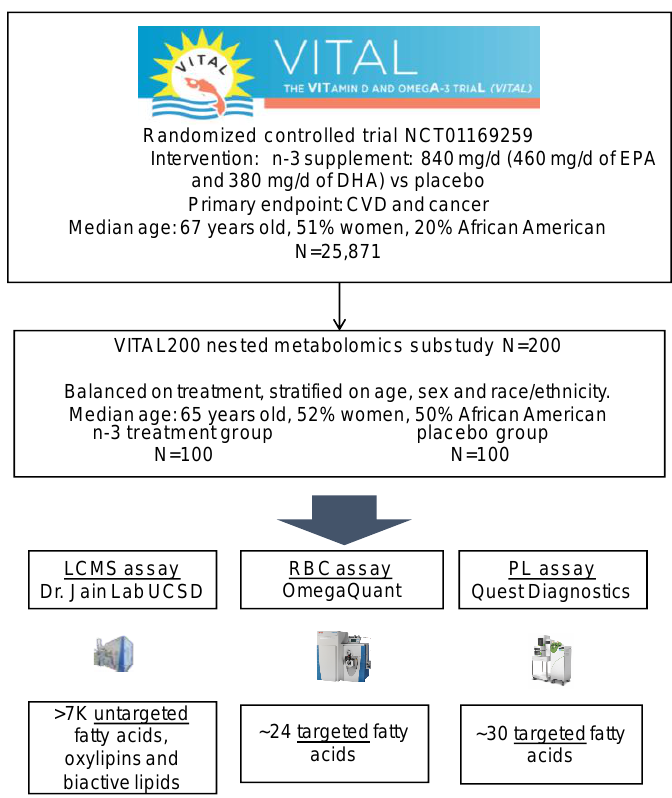
Figure A1. VITAL200 design. Assays: LCMS — high-throughput liquid chromatography – mass spectrometry of circulating free FAs, oxylipins and bioactive lipids from plasma; RBC — gas chromatography with flame ionization detection for red blood cells; PL — LCMS2 plasma phospholipids.